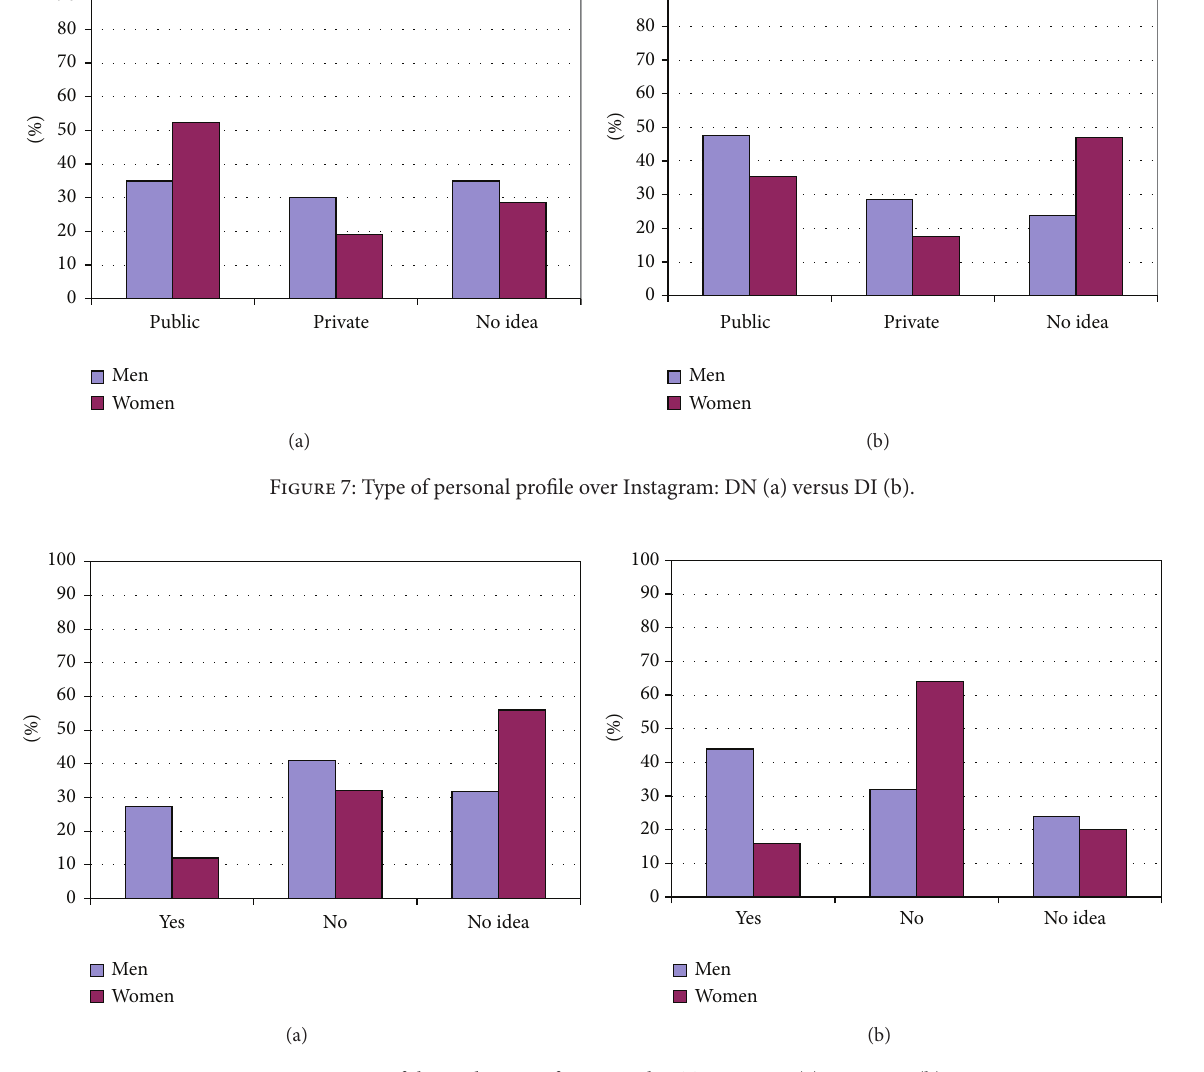
Figure 8: Usage of the geolocation feature within Twitter: DN (a) versus DI